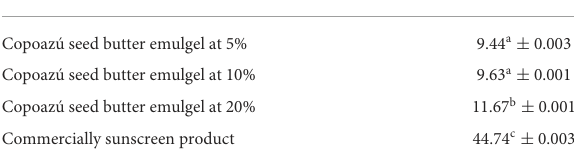
TABLE 2 SPF found in the emulgels